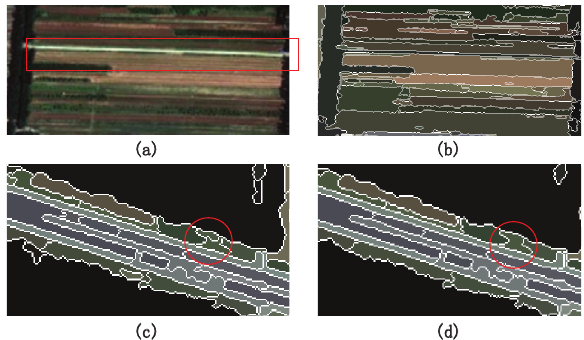
Figure 5. (a)Origin Image (b)First merging result (c)First merg- ing result (d)Second merging result